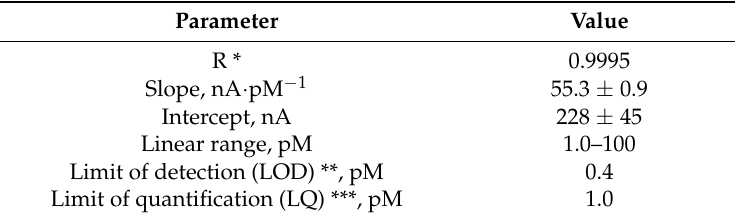
Table 3. Analytical characteristics obtained for the determination of miRNA-21 with the developed biosensor.